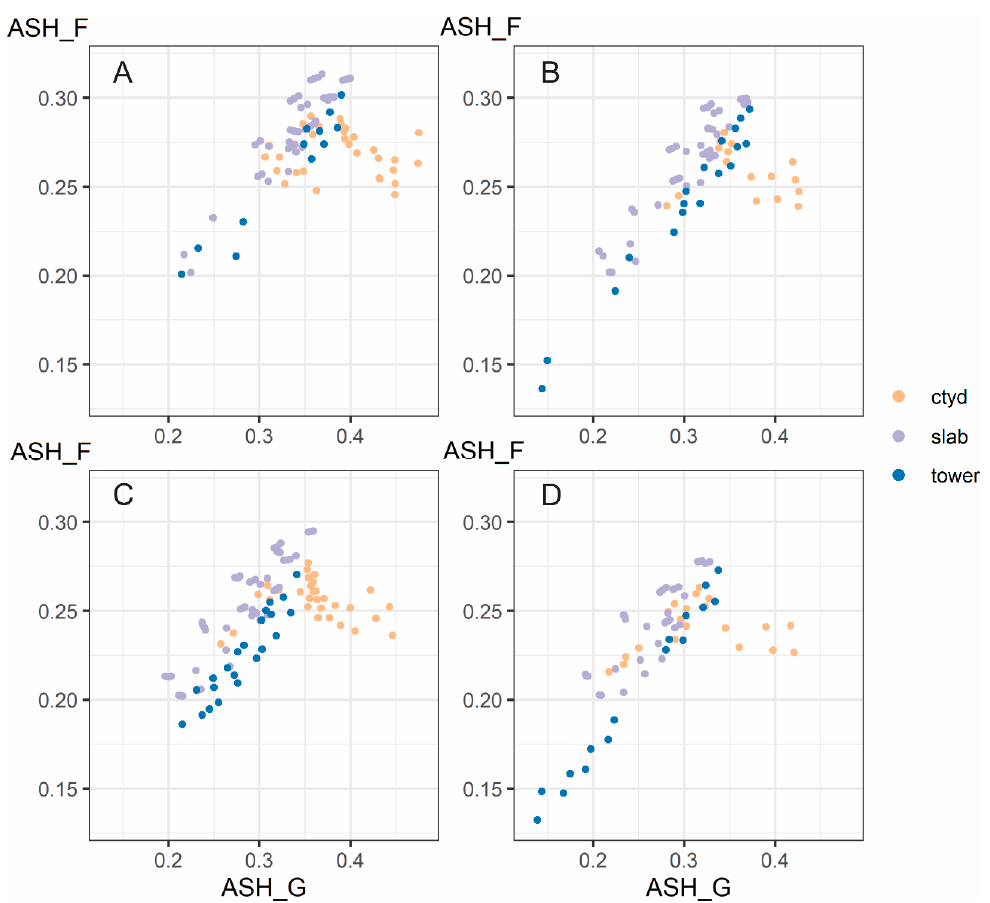
Figure 27. Selected neighbourhood cases presented as relation graphs based on the ASH on ground and façade. The graphs show cases with FAR in range of ( A ): (1.4–1.49), ( B ): (1.5–1.59), ( C ): (1.6– 1.69), ( D ): (1.7–1.79).